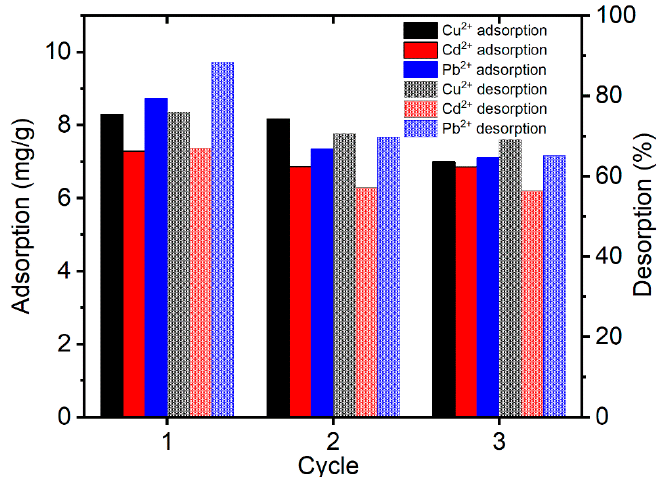
Figure 8. Consecutive adsorption–desorption cycles of heavy metal cations (Cu 2+ , Cd 2+ , Pb 2+ ) onto the solid surface of oxidized wool fibers